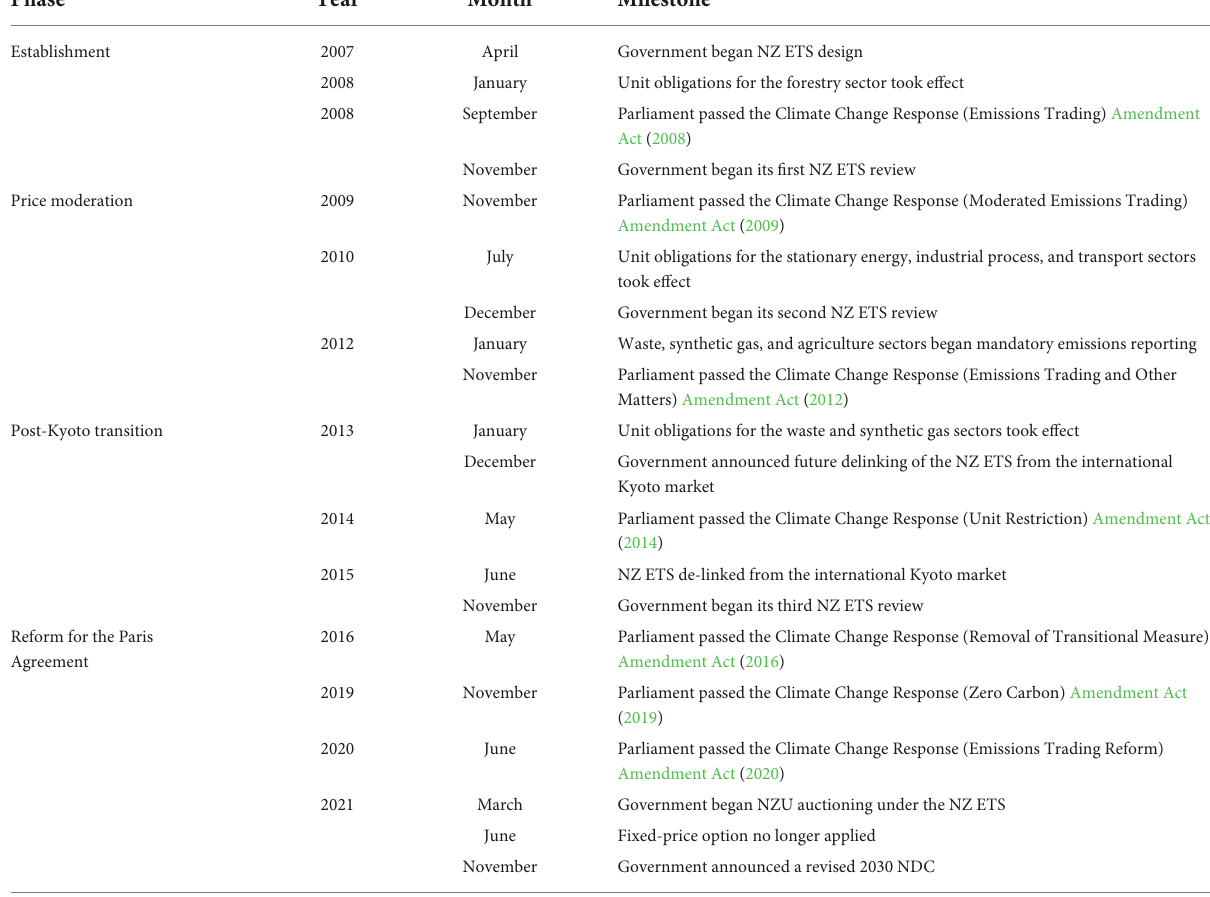
TABLE 1 Key milestones in the operation of the NZ ETS. Adapted from Leining (2022).